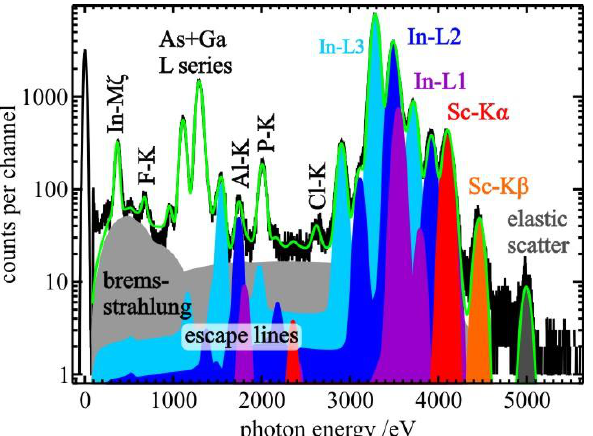
Figure 3. Fluorescence spectrum (black line) of the sample ID8 with one ALD cycle for Sc O excited by a 5 keV X-ray beam under a glancing angle of 0.5° at the FCM beamline. 2 3 The deconvolution of the spectrum was performed by fitting a model spectrum (green line) employing the detector response functions. The indium fluorescence line series were fitted using constant line sets [23] for each sub-shell (light blue, blue and